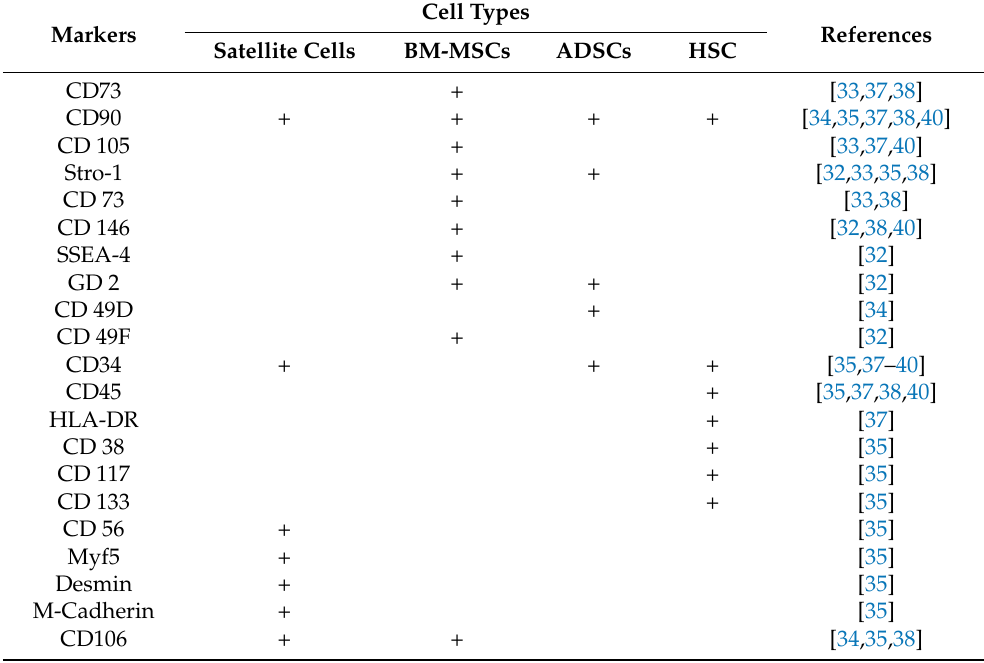
Table 1. Molecular markers in different myogenic stem cell populations compared to hematopoietic stem